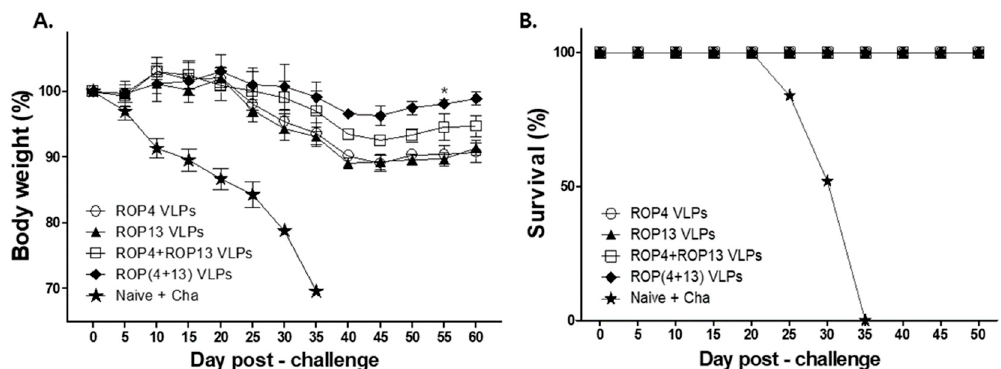
Figure 8. Protective efficacy of immunization with T.gondii VLPs. Naïve or immunized mice ( n = 5) were orally infected with 450 T. gondii ME49 cyst after boost immunization. Mice were monitored for 60 days to observe changes in body weight ( A ) and survival ( B ) after challenge infection. Upon challenge infection, all immunized mice survived and ROP(4 + 13) VLPs immunization showed the least weight loss, whereas all naïve challenge mice showed rapid weight loss and died on day 35.